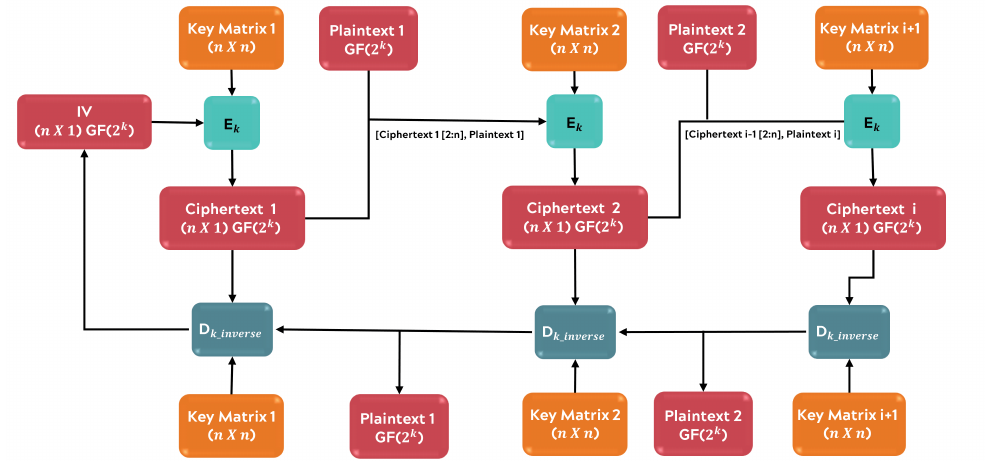
Figure 2. Cipher Feedback Mode (CFB) mode of cryptographic